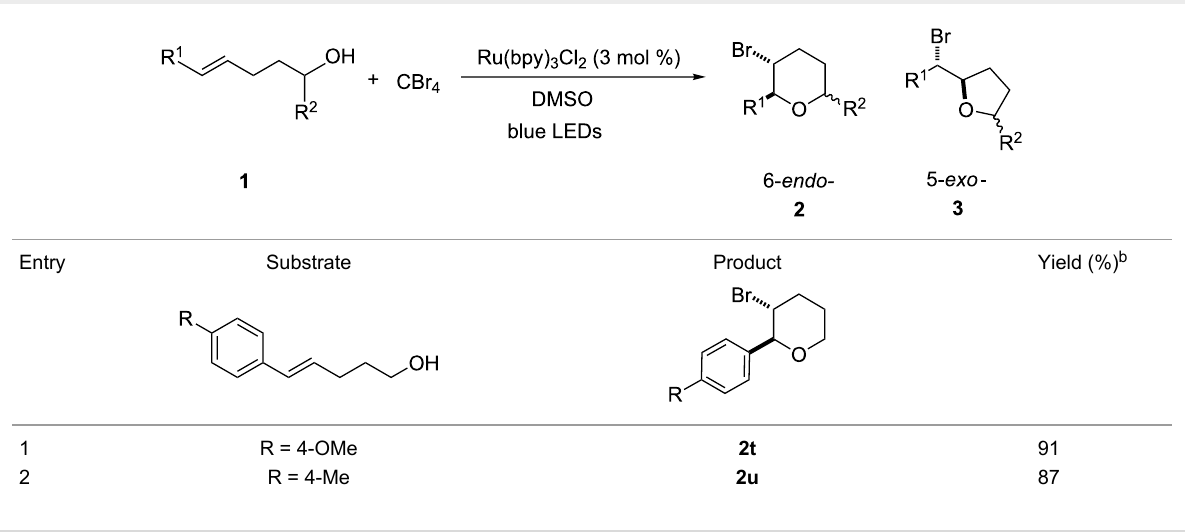
Table 3: Photocatalytic bromoetherification of pentenols a